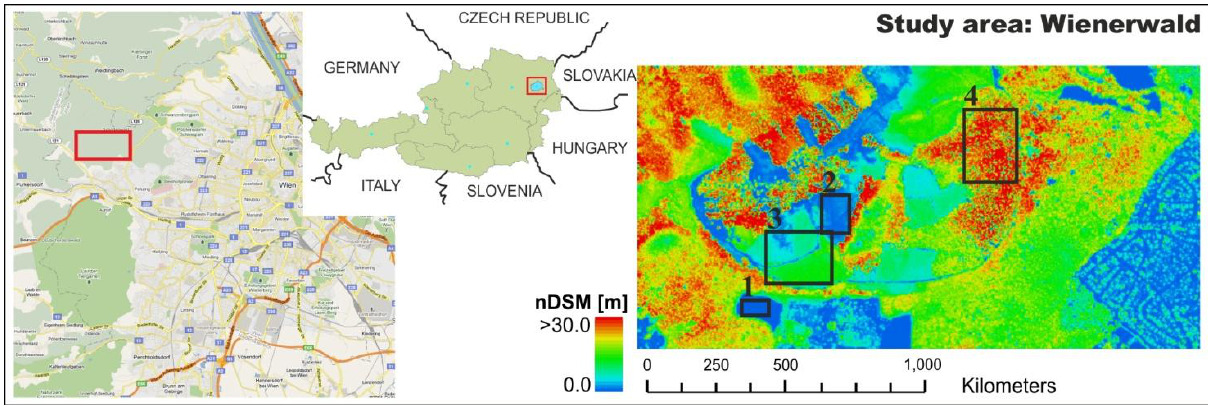
Figure 2. Overview of the study area Wienerwald located at the western border of the city Vienna (UTM33N, LE: 590450, 5341300, UR: 592450, 5342350). In the subareas 1–4 additional analyses are done (see Section